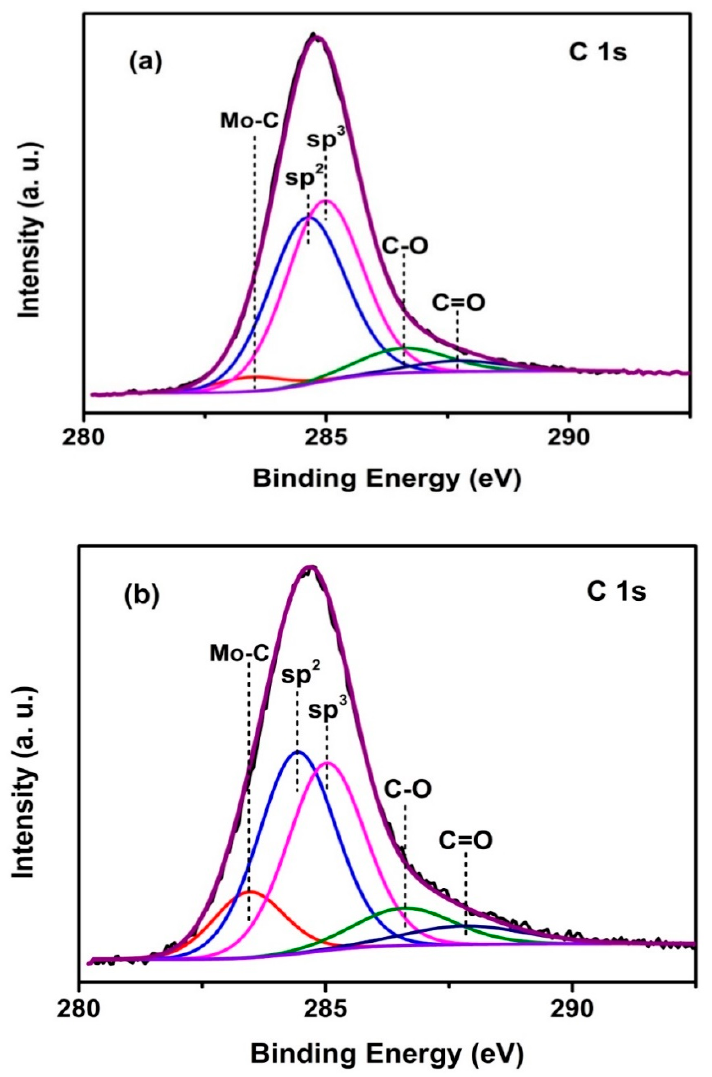
Figure 3. Curve-fitted C 1s core level spectra of Mo-DLC coatings: ( a ) 3.9 at.% Mo and ( b ) 16.2 at.% Mo.